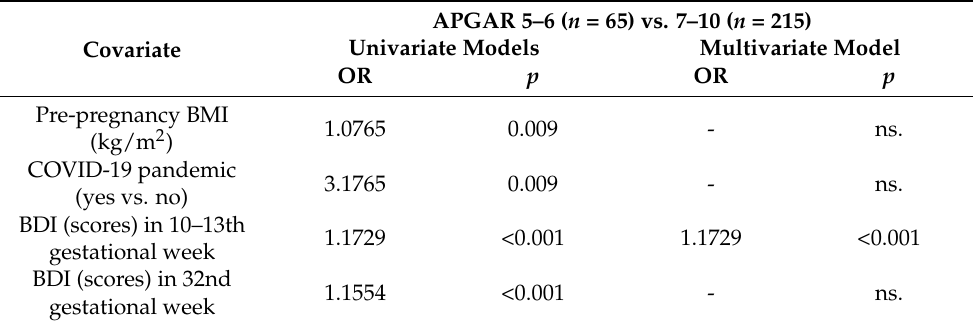
Table 4. Univariate and multivariate logistic regression models of APGAR’s score against pre- pregnancy BMI, COVID-19 pandemic, and severity of